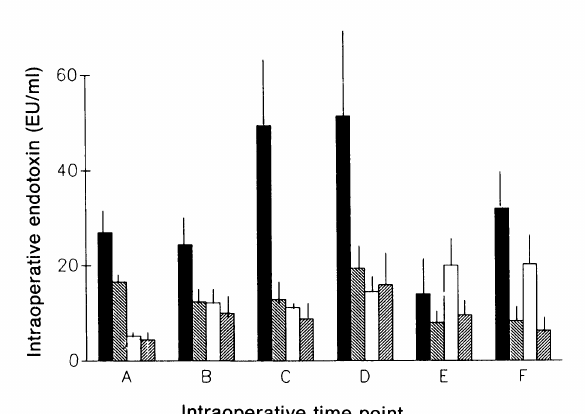
FIG. 1. Intraoperative course of endotoxin (ET) in four subgroups of liver transplant recipients (n 38), classified according to their ET plasma concentrations at the beginning (A) and end (F) of grafting. Group (n 6), +A +F; group 2 (n 6), +A -F; group 3 (n 5); -A + F; and group 4 (n=21), -A -F. Blood samples were collected intraoperatively after incision of the skin (B), at the beginning of the anhepatic phase (C), at the end of the anhepatic phase (D), 5 rain following recirculation (E) and at the end of operation (F). Mean values (-t-S.E.M.) are given as endotoxin units (EU).., Group 1; I, group 2; I-q, group 3; I, group